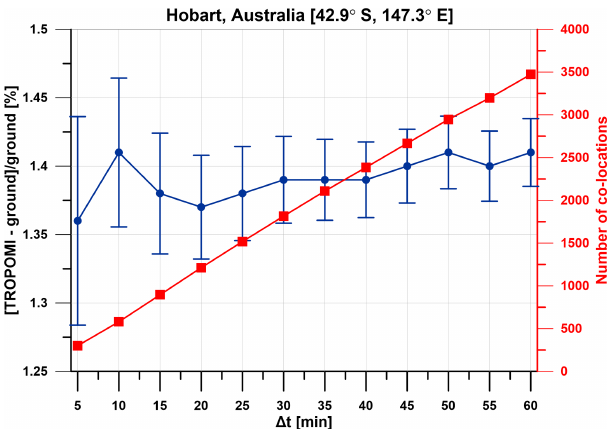
Figure 2. The effect of the temporal variability of the sensing be- tween satellite and ground-based measurements. The mean bias and the standard error (blue data points with error bars) for comparisons at Hobart station, Australia, remain almost invariable for temporal differences greater than 40min. The red squares represent the num- ber of co-locations in each